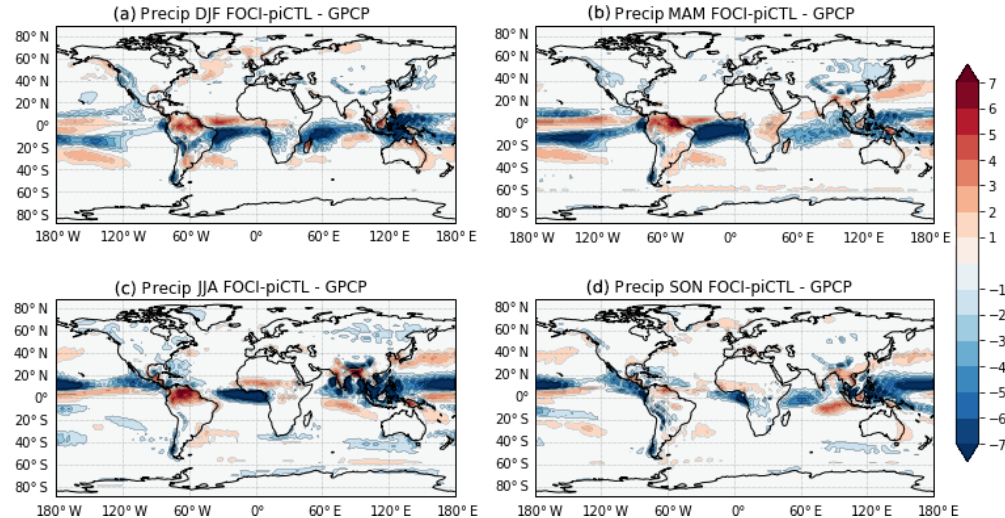
Figure A2. Seasonal mean precipitation bias – (a) DJF, (b) MAM, (c) JJA and (d) SON – with respect to the GPCP dataset (1979–2013).